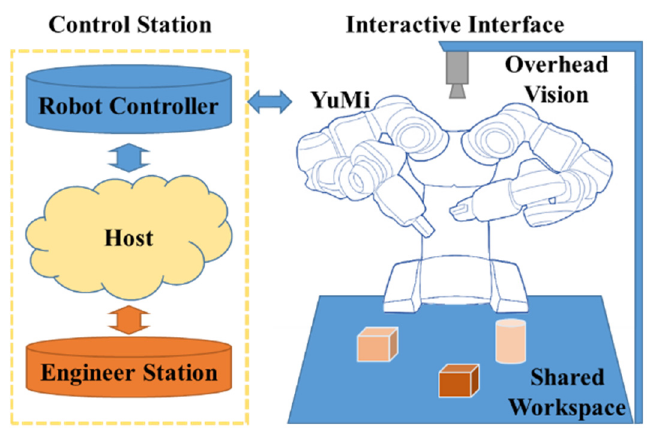
Figure 3. The collaborative research platform.